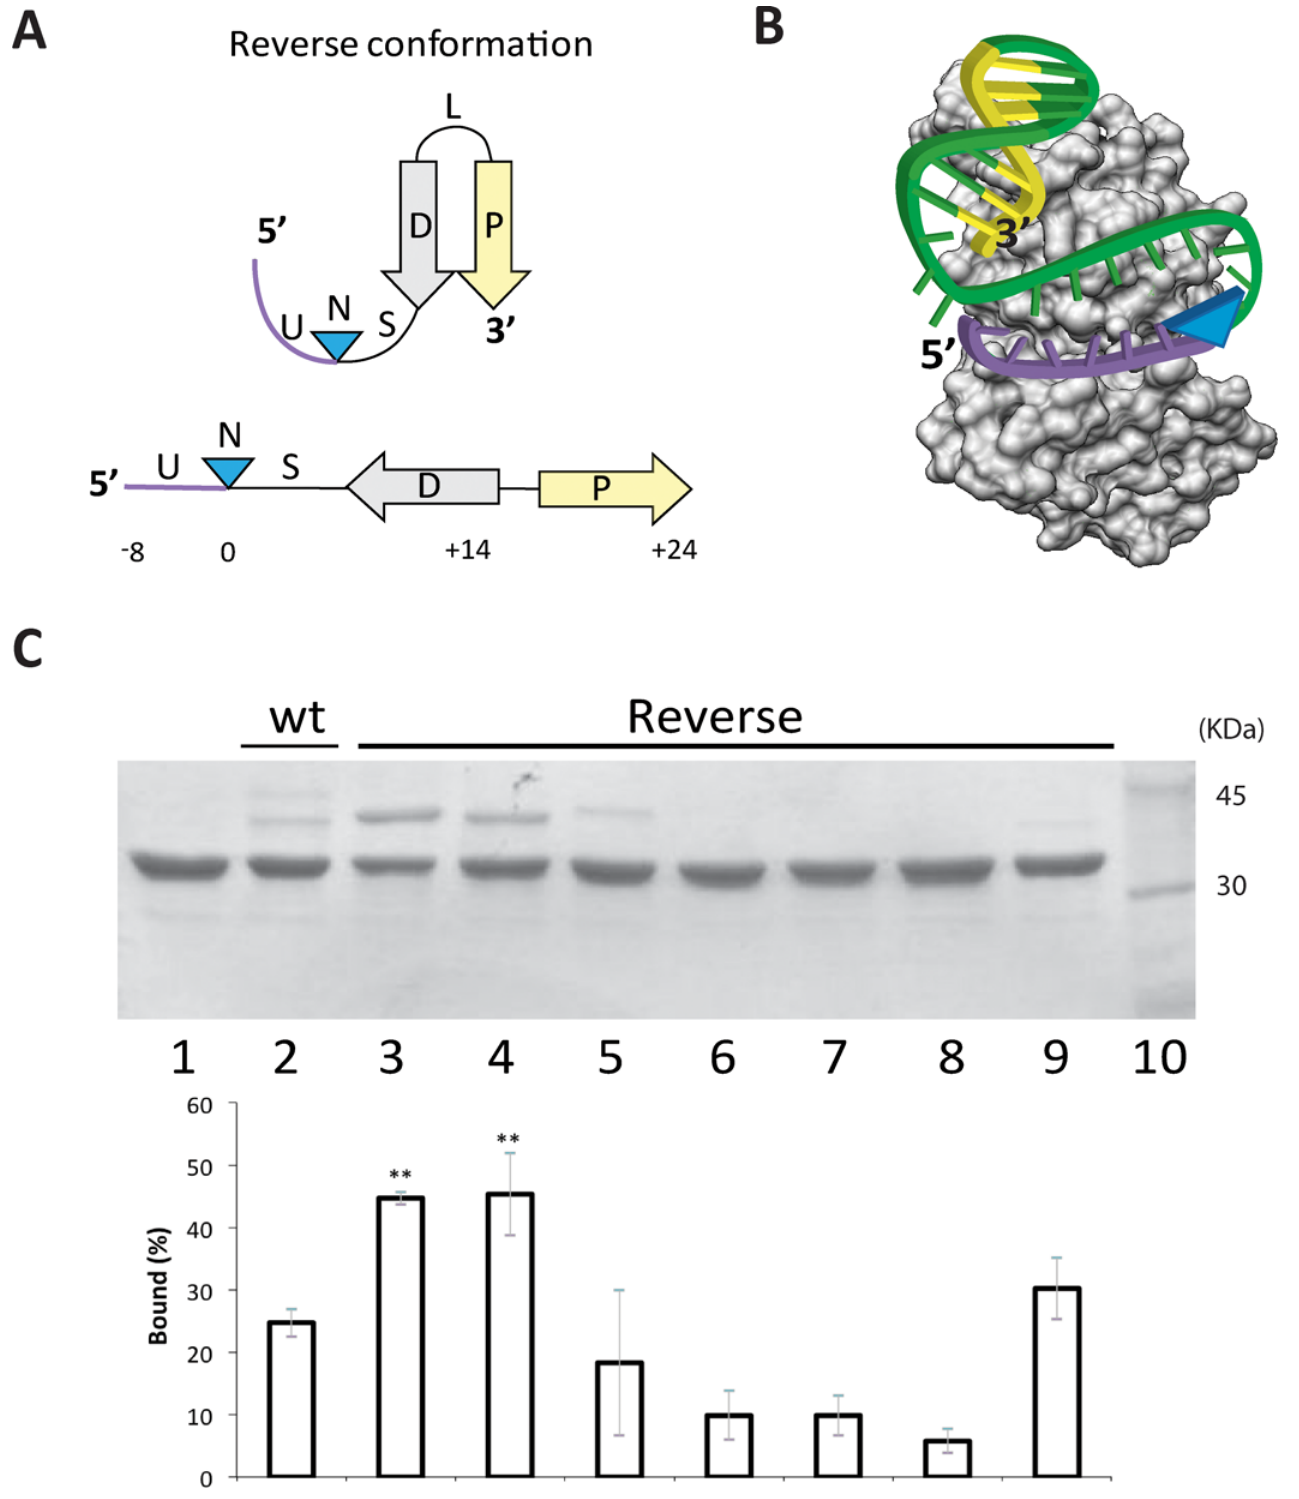
Fig 4. Interaction of TrwC R with Reverse substrates. (A) Reverse substrates were designed by swapping the 5 ’ region of the nic site to the 3 ’ end. This designed DNA substrate possesses the complete inverted repeat (D-P) at the 3 ’ end of the nic site (N). Either the U or the S lengths were tuned to allow the correct location of the hairpin within the relaxase binding domain. (B) Scheme depicting the cleavage reaction of the reverse substrate. Relaxase binding to